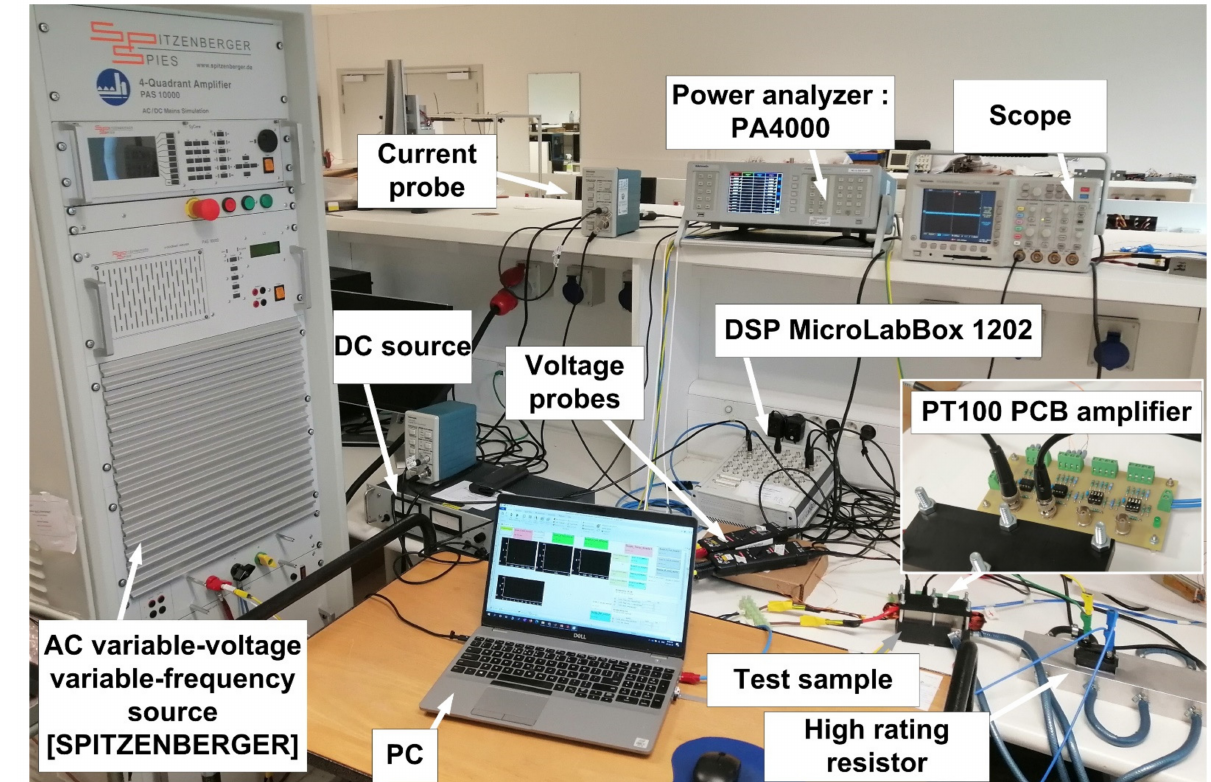
Figure 8. Photograph of the complete test setup.